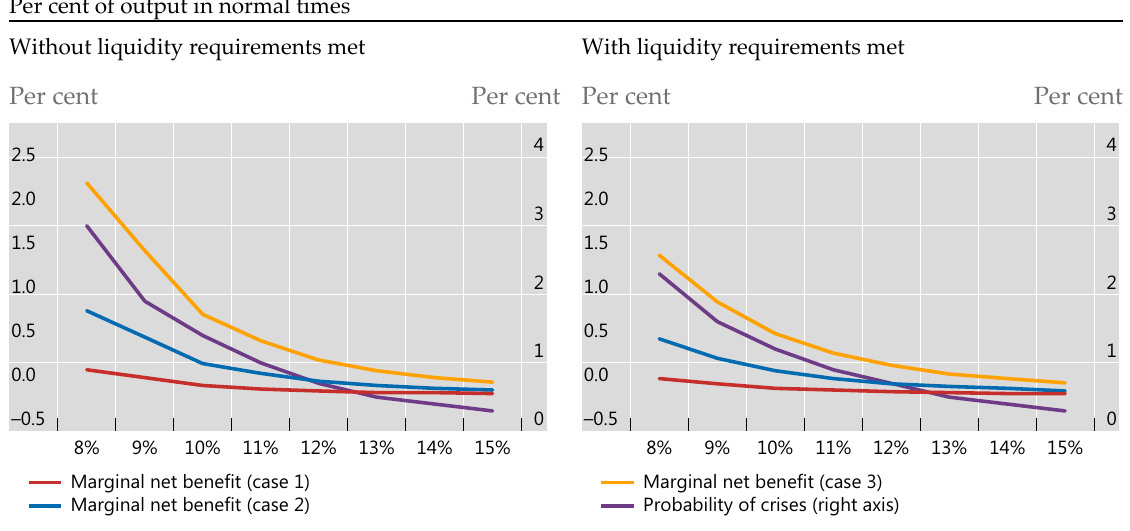
Figure A1. Net marginal benefits of higher capital ratios in BCBS (2010).